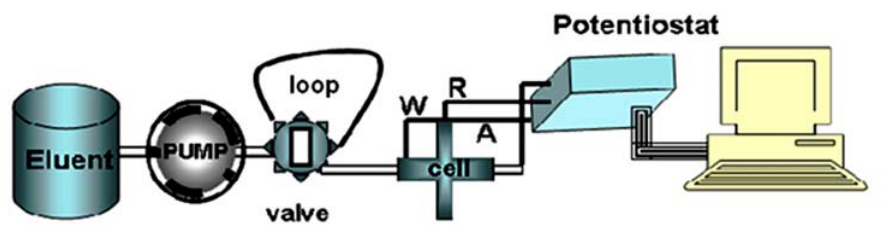
Figure 1. The schematic of the flow injection